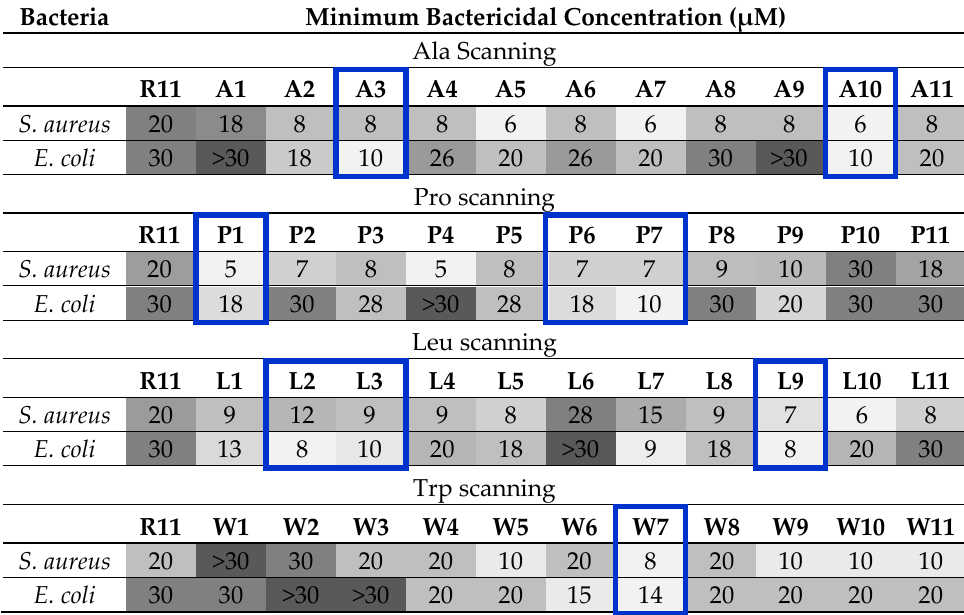
Table 1. Antibacterial activity against S. aureus and E. coli for R11 scanning. MBC is expressed in µ M. The results are shaded in gray with the lowest values in light and the highest in dark. Blue boxes indicate peptides with lowest MBC for both bacteria.